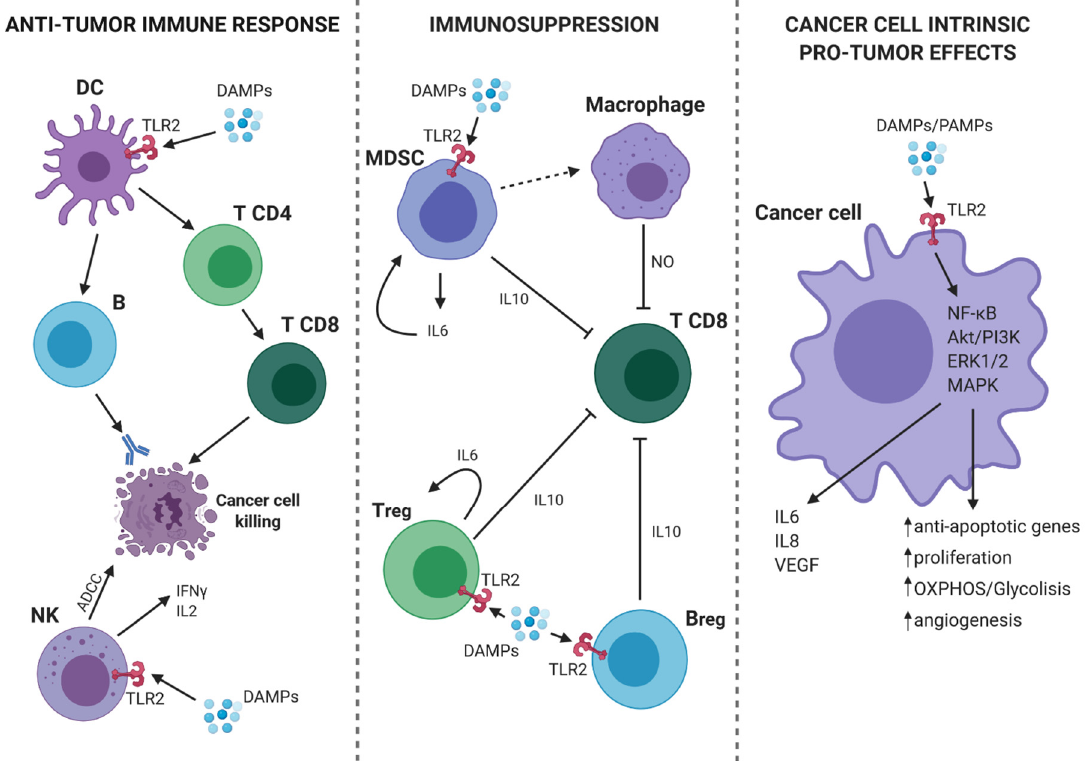
Figure 2. TLR2-mediated pro- and anti-tumor mechanisms. (On the left) In tumor microenvironment (TME), the presence of DAMPs activates dendritic cells (DCs) through TLR2. Consequently, DCs present the antigen and initiate a specific anti-tumor T cell response. At the same time, TLR2 expressed on Natural Killer (NK) cells mediates their activation and the induction of antibody-dependent cell-mediated cytotoxicity (ADCC) against cancer cells as well as the release of IFN- γ and interleukin (IL)-2. (On the center) TLR2 activation on myeloid-derived suppressor cells (MDSCs), Bregs and Tregs leads to an immunosuppressive e ff ect. Indeed, MDSCs can induce macrophages to release nitric oxide (NO) that suppresses the activity of T CD8 + lymphocytes. Moreover, activated MDSCs, Bregs and T regulatory cells (Tregs), release IL-6 and IL-10 with the consequent synergic inhibitory e ff ect on T CD8 + cells. (On the right) TLR2 expressed on cancer cells can bind DAMPs / PAMPs and activate intracellular signaling, such as nuclear factor kappa-light-chain-enhancer of activated B cells (NF- κ B), Akt / PI3K, extracellular signal-regulated kinase (ERK)1 / 2, and MAPK. The consequence is a pro-tumor e ff ect due to the release of IL-6, IL-8, VEGF, and the promotion of proliferation, cell metabolism, angiogenesis, and protection from apoptosis. Continous and dashed arrows indicate activation or secretion. T-arrows indicate cellular inhibition. Created with BioRender.com.